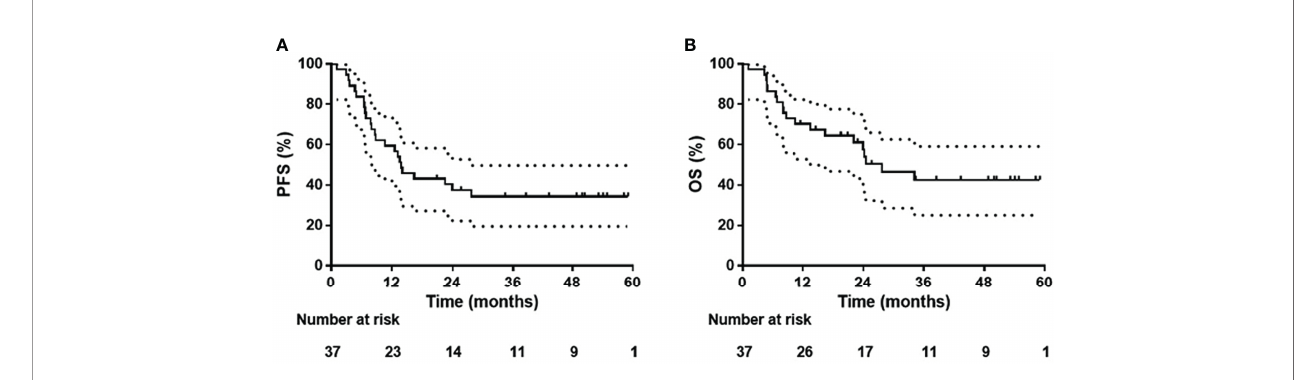
FIGURE 2 | (A) Progression-free survival and (B) overall survival curves for 37 patients.